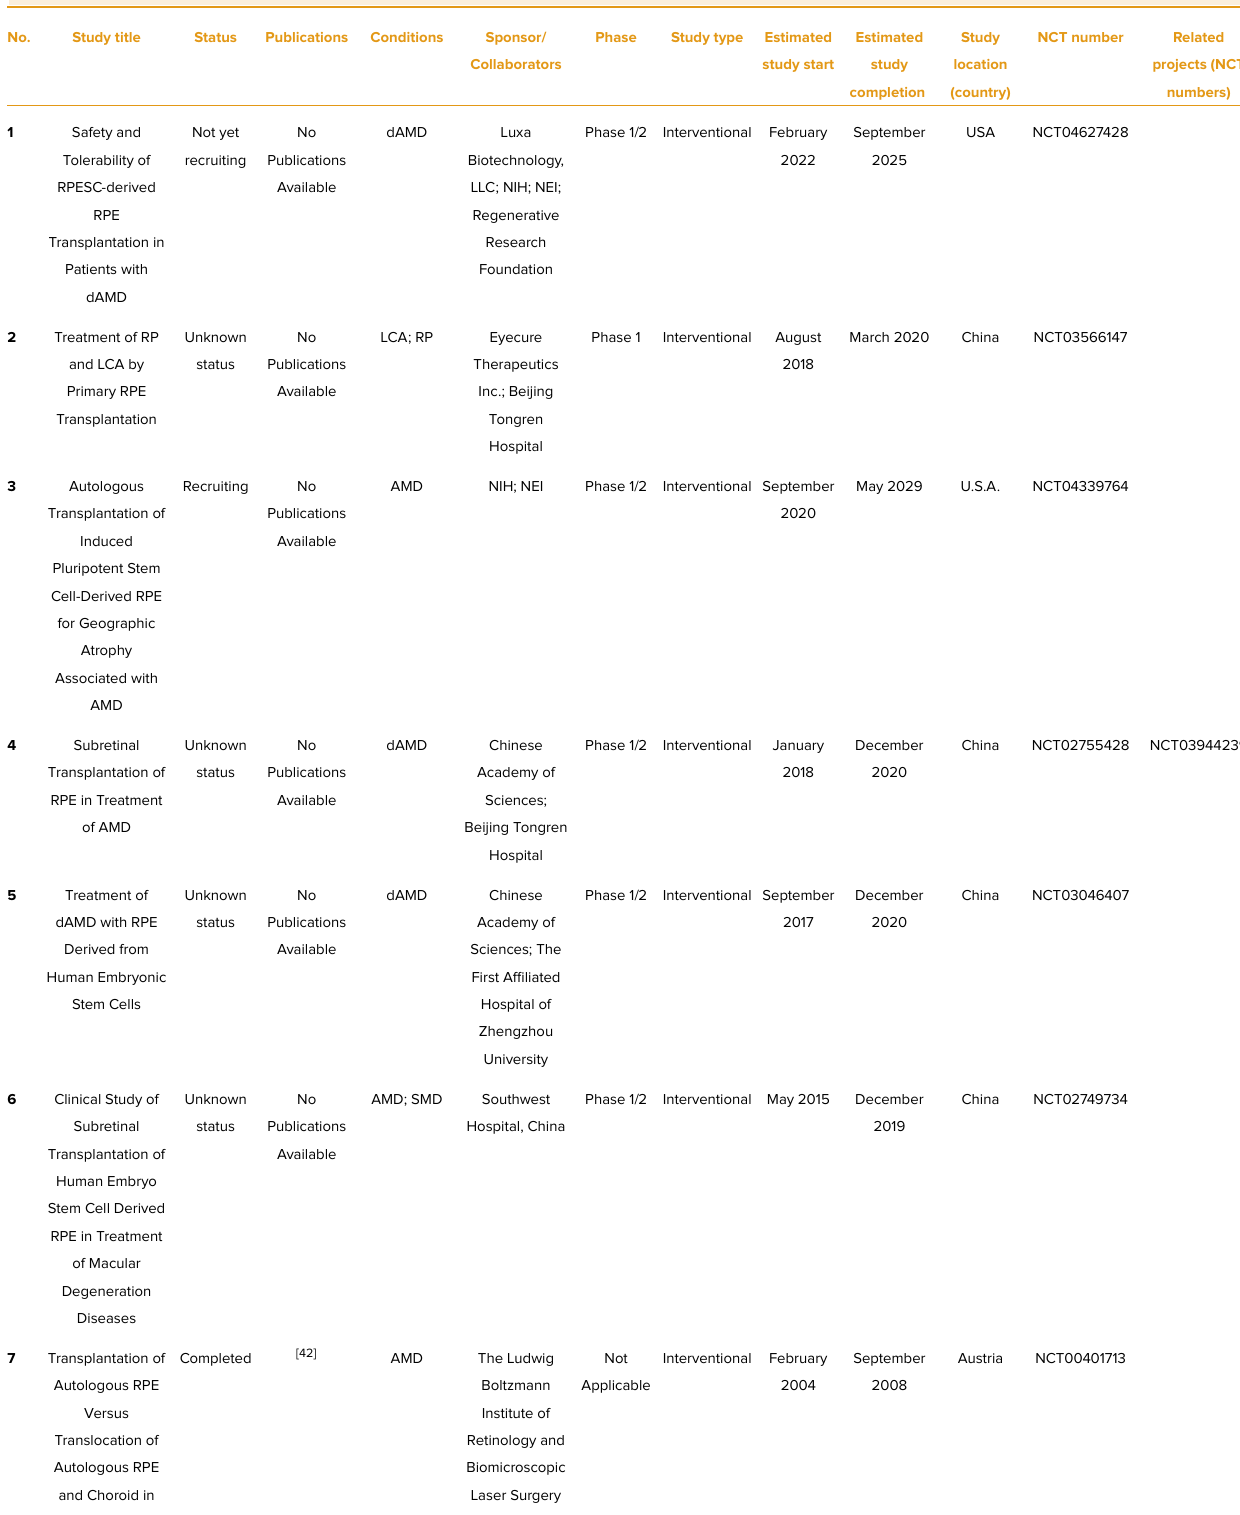
Table 1. RPE transplantation trials listed on ClinicalTrials.gov.